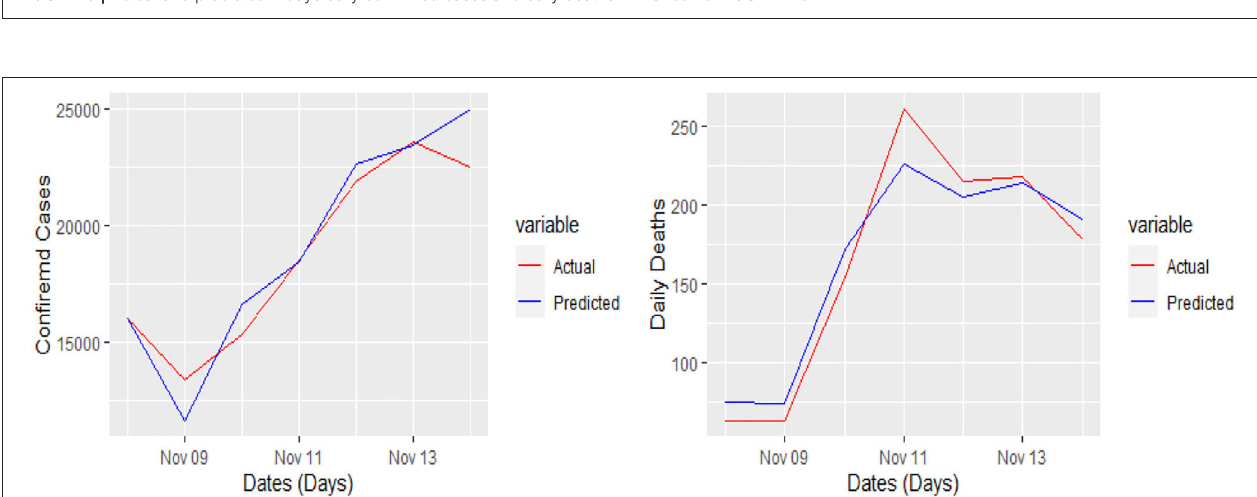
Frontiers in Public Health | www.frontiersin.org 13 July 2022 | Volume 10 | Article